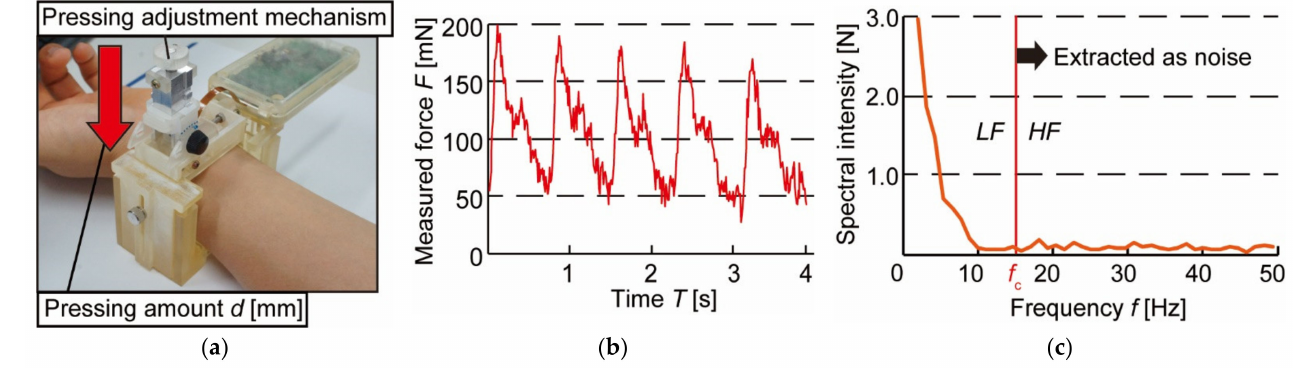
Figure 6. Experimental conditions and results of blood pressure pulse wave measurement: ( a ) Exper- imental setup; ( b ) Waveform of blood pressure pulse wave; ( c ) Fourier transformed blood pressure pulse wave.